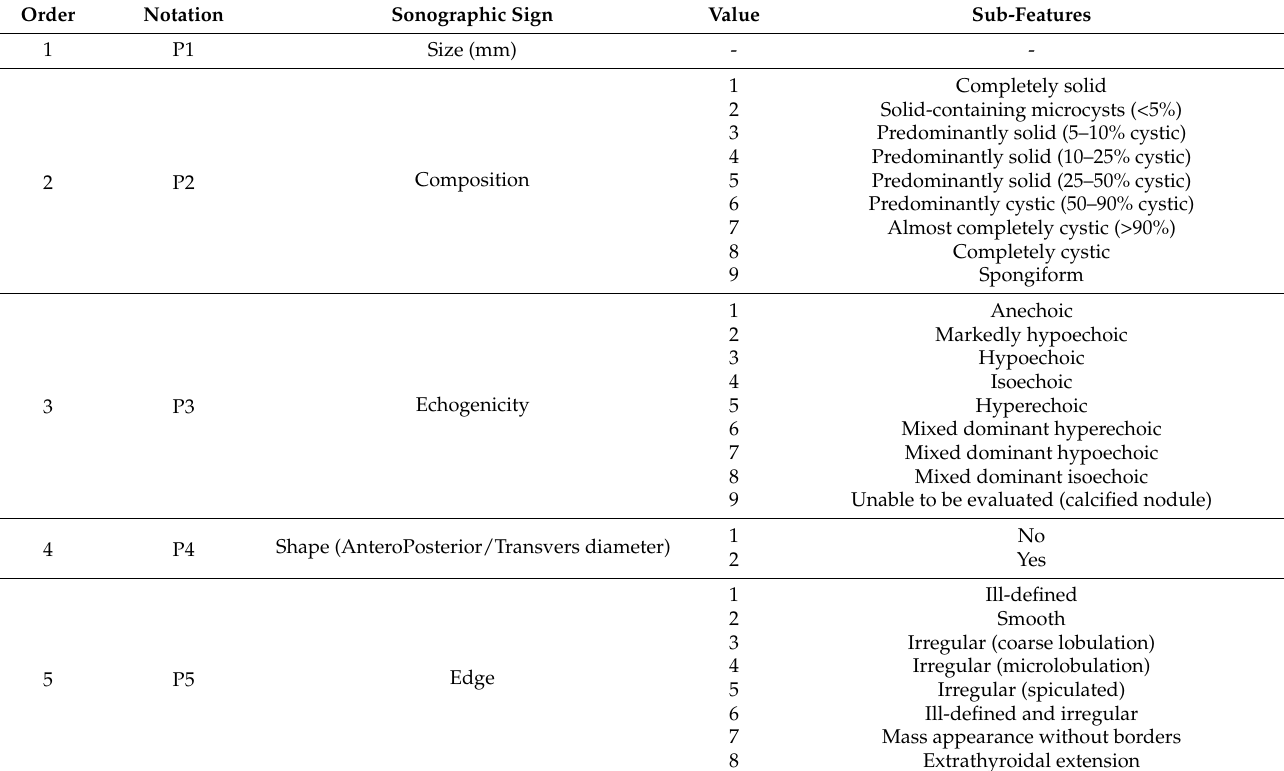
Table 1. 27 Sonographic signs of nodules evaluated in study